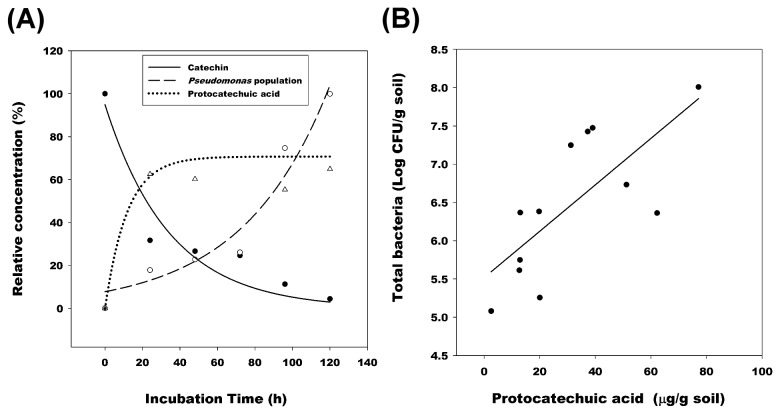
Relative concentrations of (-)-catechin and protocatechuic acid, and the bacterial population in the medium, during 120 h incubation with Pseudomonas sp. CRF3-Ps-1.(●) Relative concentration of catechin (r = -0.958, P = 0.0025, n = 6); (○) Bacterial population of Pseudomonas CRF3-Ps-1 (r = 0.974, P = 0.001, n = 6); (△) Relative concentration of protocatechuic acid (r = 0.874, P = 0.0226, n = 6). (B) Correlations between the concentration of protocatechuic acid and bacterial populations in the soil of R. formosanum (r = 0.734, P = 0.0066, n = 12).